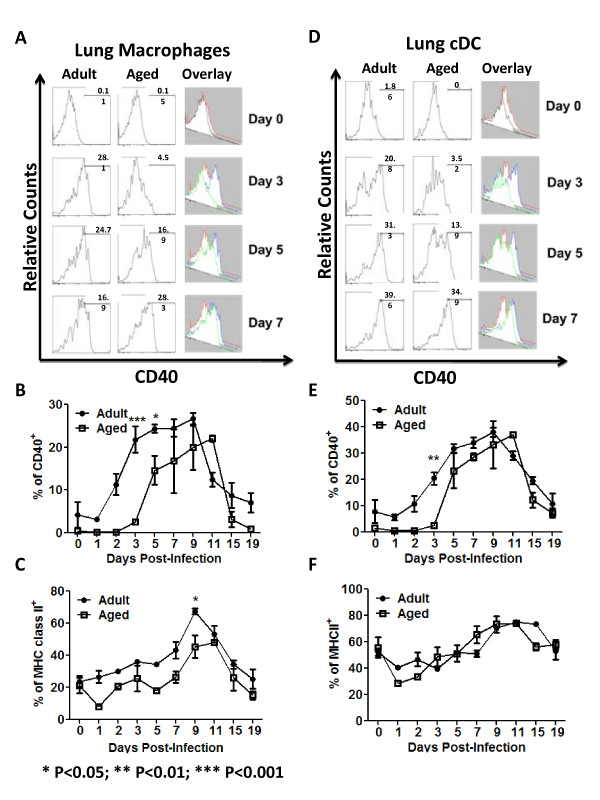
Innate Cells Activation. The expression of CD40 and MHC class II was assayed in lung macrophages and cDCs (R6 and R3 in Fig 2B, respectively). Example of expression of CD40 by these cells is shown in adult (first column) and aged (second column) animals at different time points (A and D). An overlay of the histograms is shown to compare differences in up-regulation (third column) of the marker. Panels B and C show upergulation of CD40 and MHC class II respectively. Panels B and C display the average of two different experiments, on which of 3 mice were assayed at each time point (a total of 6 animals per time point), bars represent SEM. Aged animals are represented in white squares and adult animals in black circles. Expression of CD40 on lung macrophages and cDCs was similar in adult and aged animals at day 0. Up-regulation of this marker was slower in aged animals and statistically significant differences were detected as early as day 3 (B and E). On the other hand, MHC class II expression at day 0 and up-regulation was similar between adult and aged animals in both lung macrophages and cDCs (C and F). For expression of activation markers an average of 500,000 events were collected. *P < 0.05. **P < 0.01. ***P < 0.001.